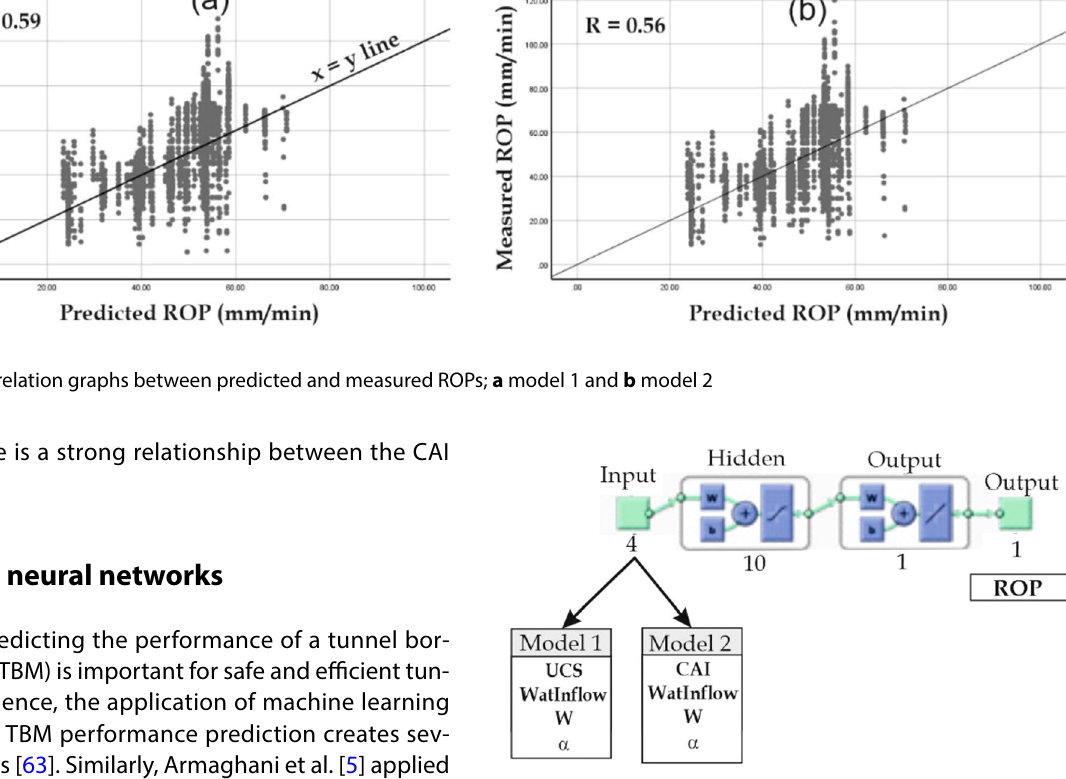
Fig. 8 General structure of the ANN models constructed in the